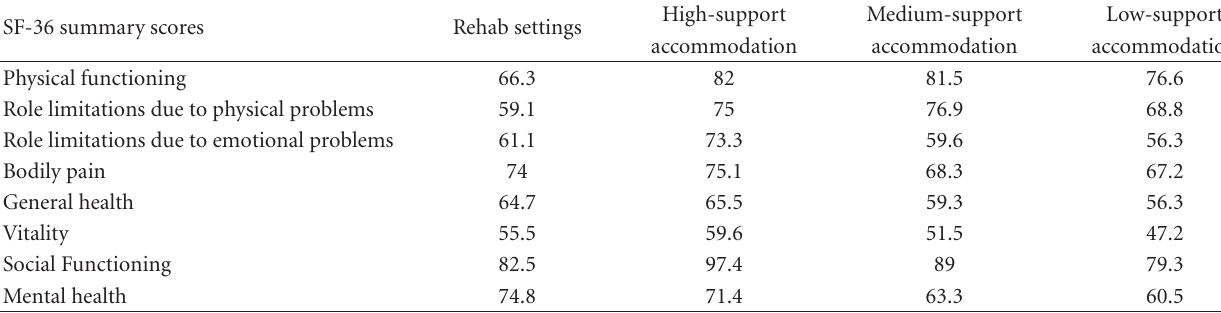
Table 2: Comparison of mean self-reported health scores (SF-36), across housing type.